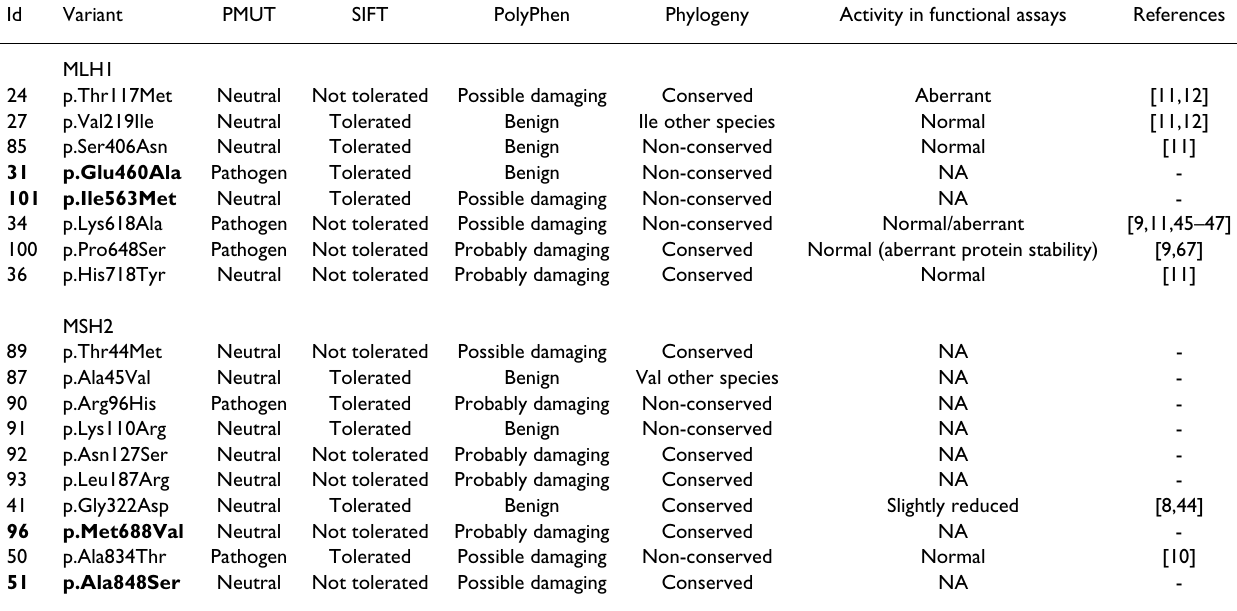
Table 5: In silico functional characterization of the missense variants Id Variant